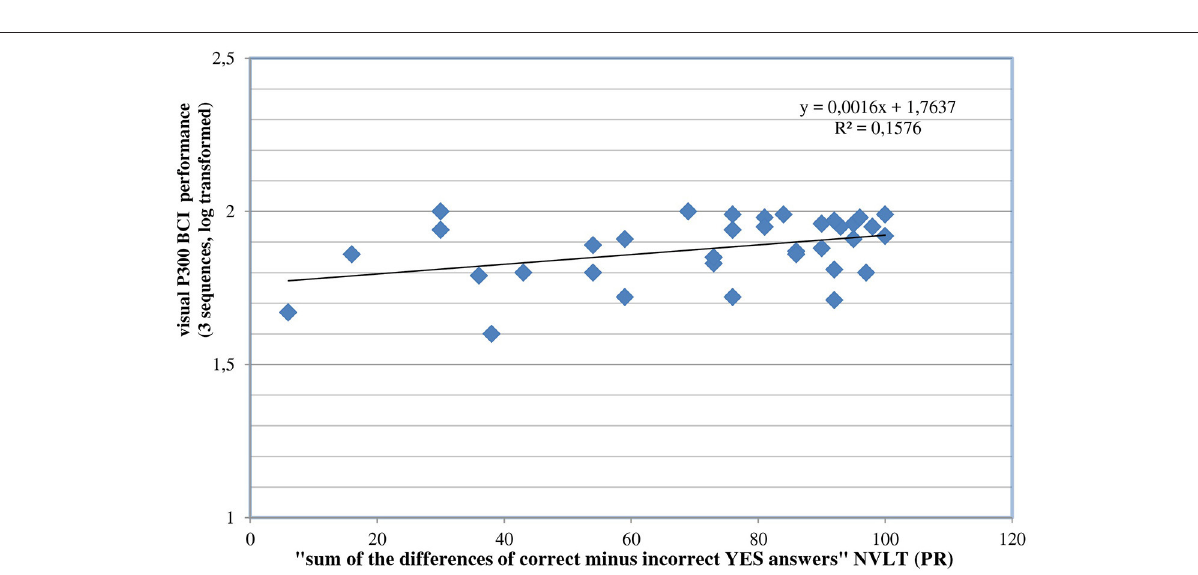
FIGURE 2 | Correlation between “sum of the differences of correct minus incorrect YES answers” (NVLT; = “the ability to learn”) and the visual P300-BCI performance after excluding two outlier